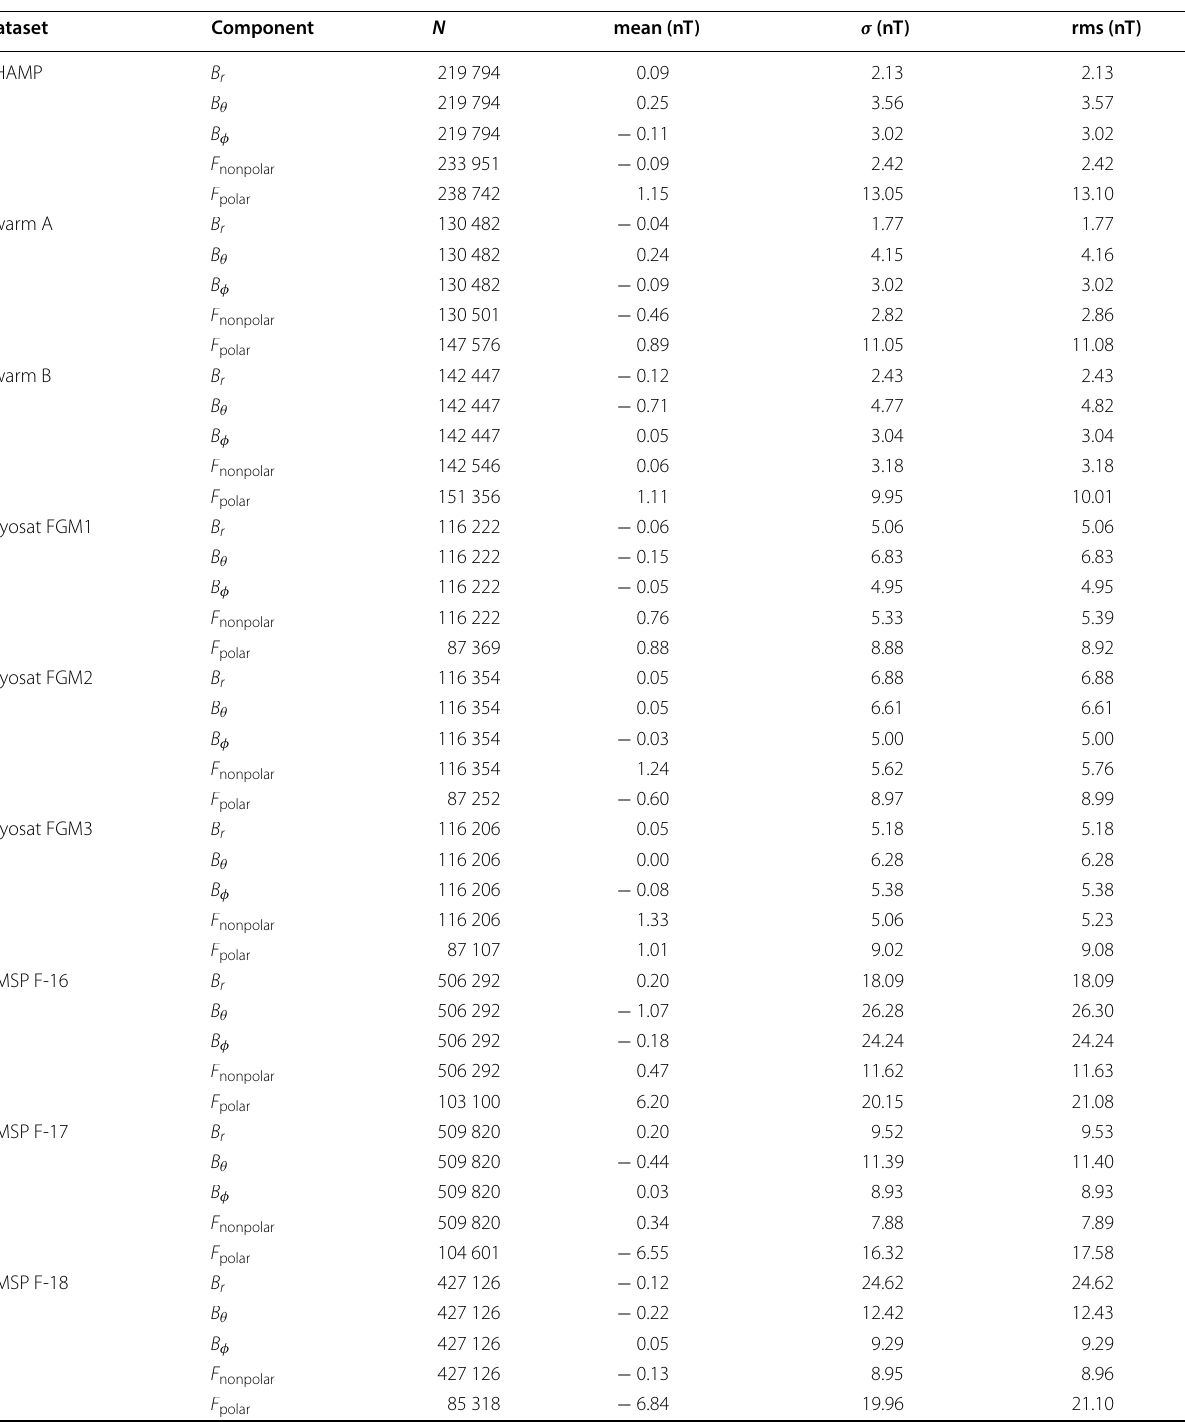
Table 3 Residual statistics (unweighted) for Model A